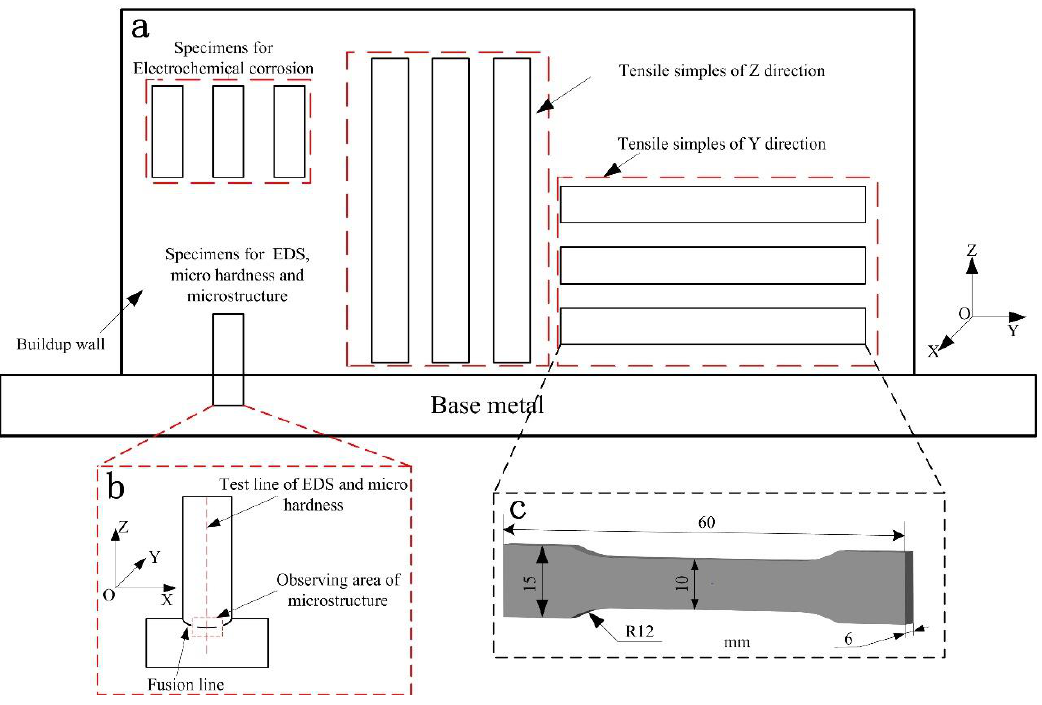
Figure 2. ( a ) Specimen extraction locations for analyses of the elemental distribution, hardness, microstructure, electrochemical corrosion, and tensile properties; ( b ) the test location for hardness and microstructure in plane XOZ ; and, ( c ) specific dimensions of tensile samples.